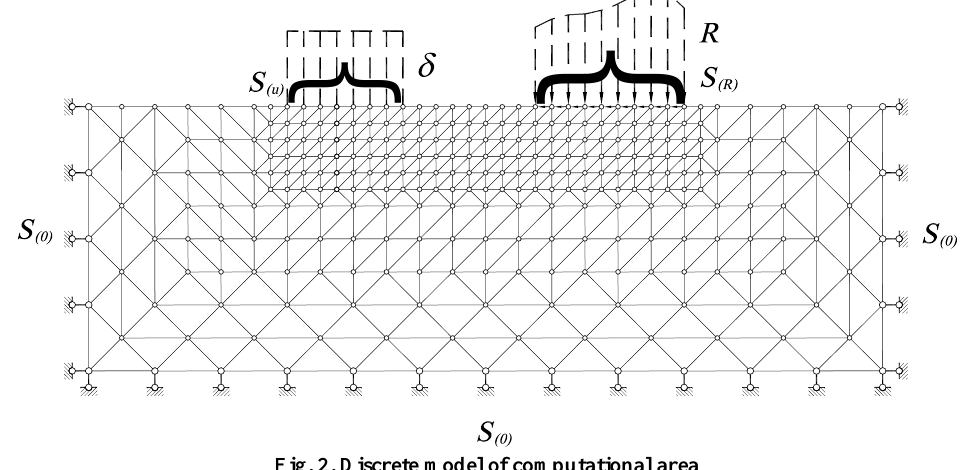
Fig. 2. Discrete model of computational area